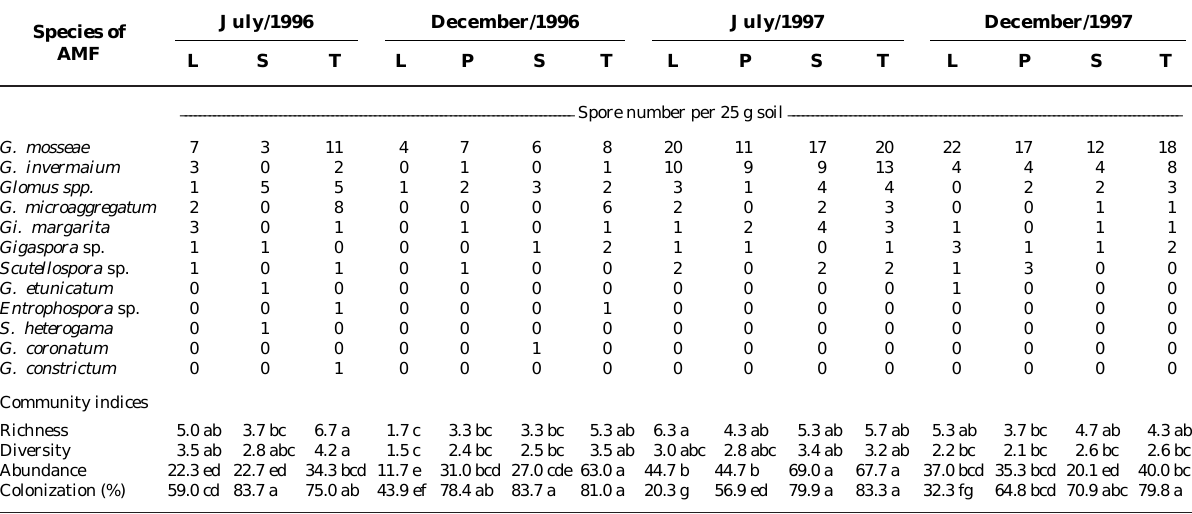
Table 7. Influence of Lolium perenne (L), Plantago lanceolata (P), Sorghum sp . (S) and Trifolium subterraneum (T) as hosts for trap cultures on populations of mycorrhizal fungi and on mycorrhizal fungal community